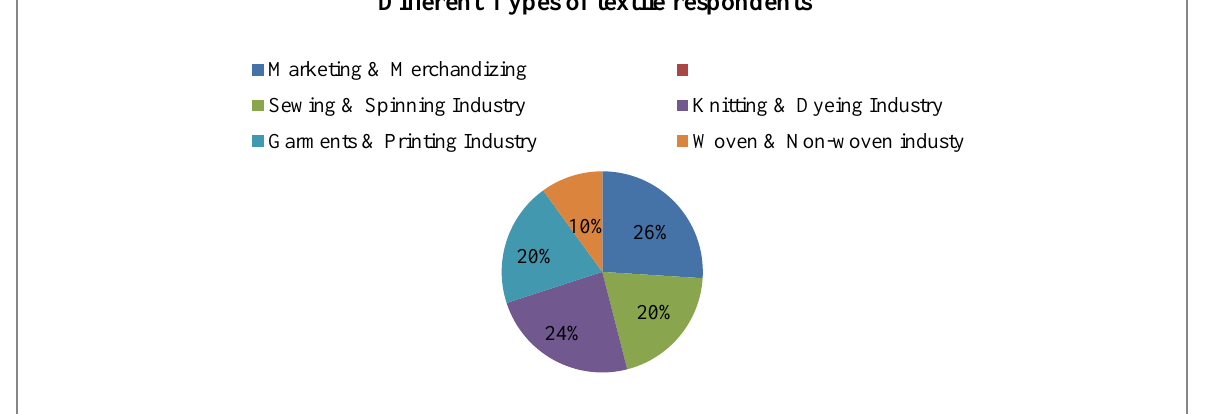
Figure 2: Different types of textiles respondents